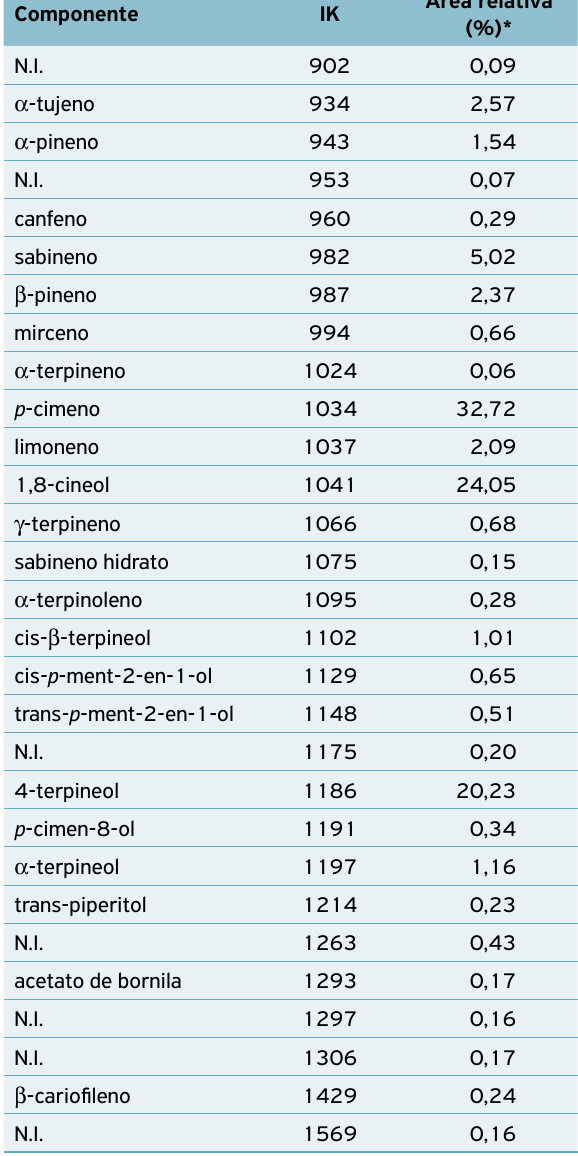
Tabela 1. Percentagem dos constituintes químicos do óleo essencial de Alpinia